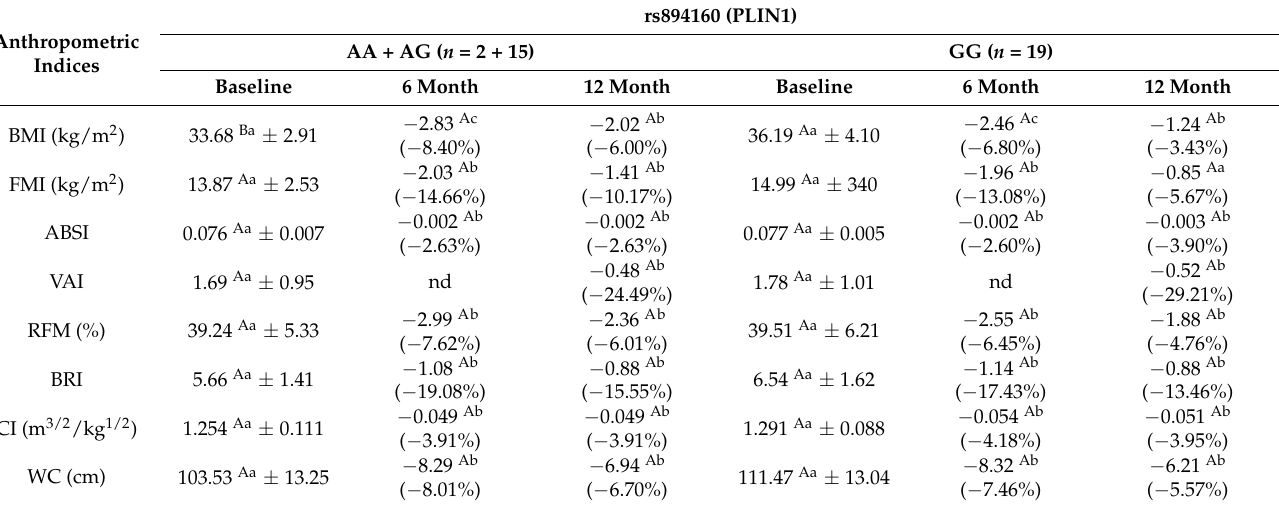
Table 7. Differences in changes in the anthropometric indices, depending on PLIN1 rs894160.